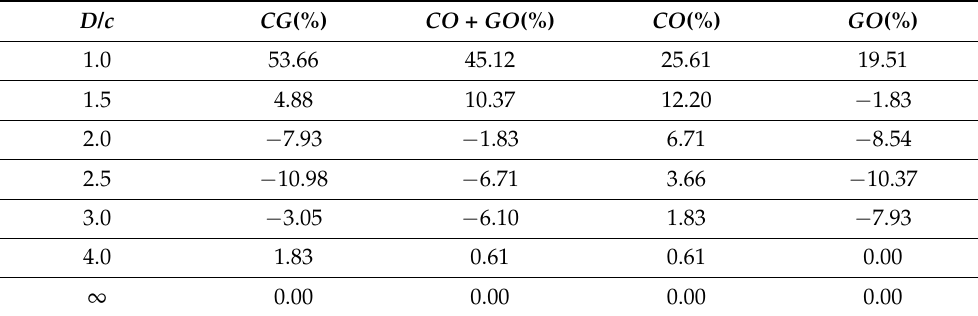
Table 2. The relative increment of cycled-averaged lift coefficient relative to the D / c = ∞ case